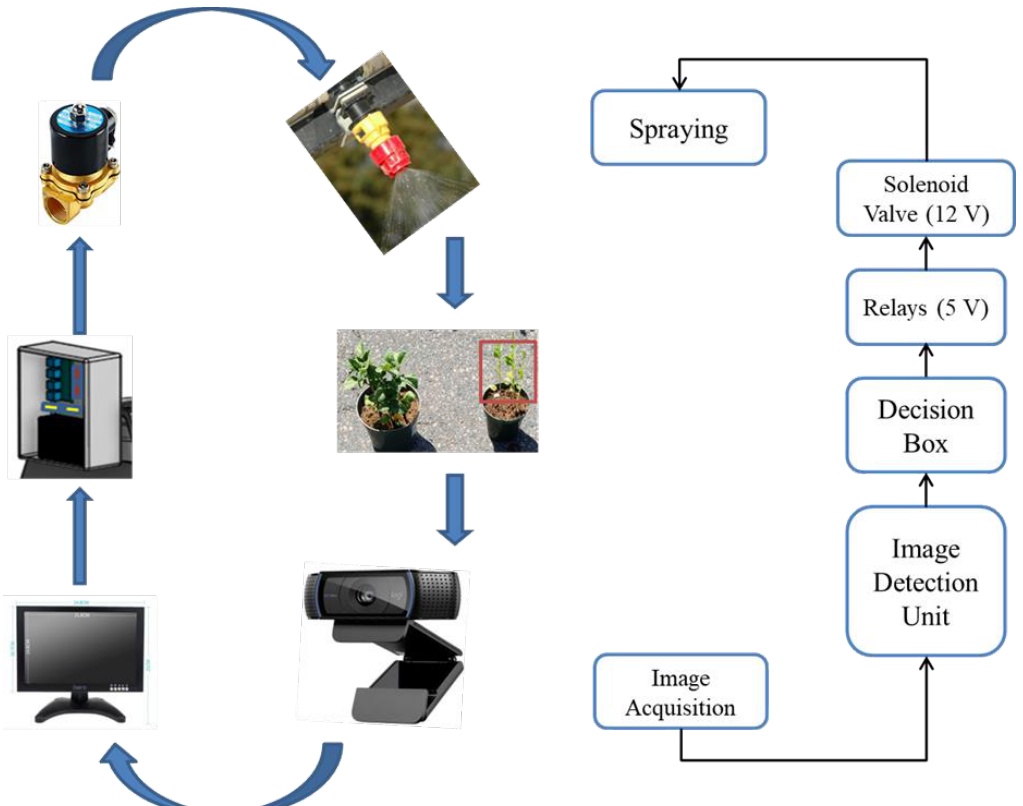
Figure 5. Flow chart of a smart variable rate sprayer for real-time detection of required weed or simulated diseased plants and targeted application of agrochemicals.